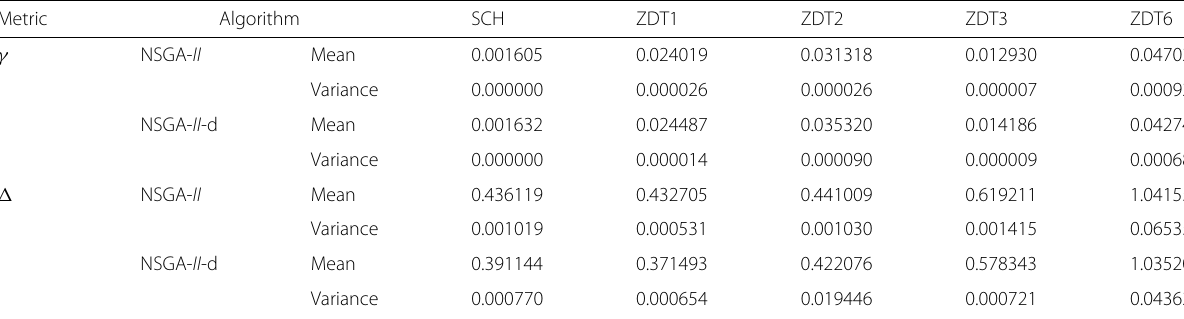
Table 2 Comparing convergence and diversity between NSGA- II and NSGA- II -d Metric